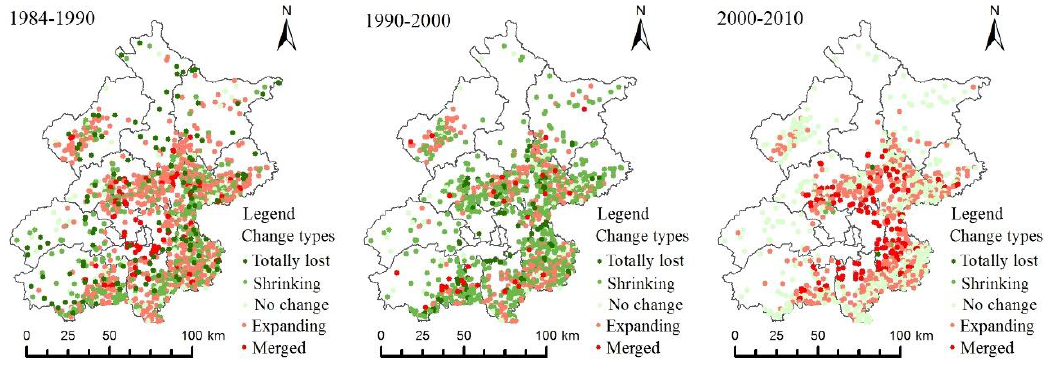
Figure 4. The spatial distribution of sampled settlements with different types of changes in Beijing. Table 5. The number of settlements in different change types in different areas.